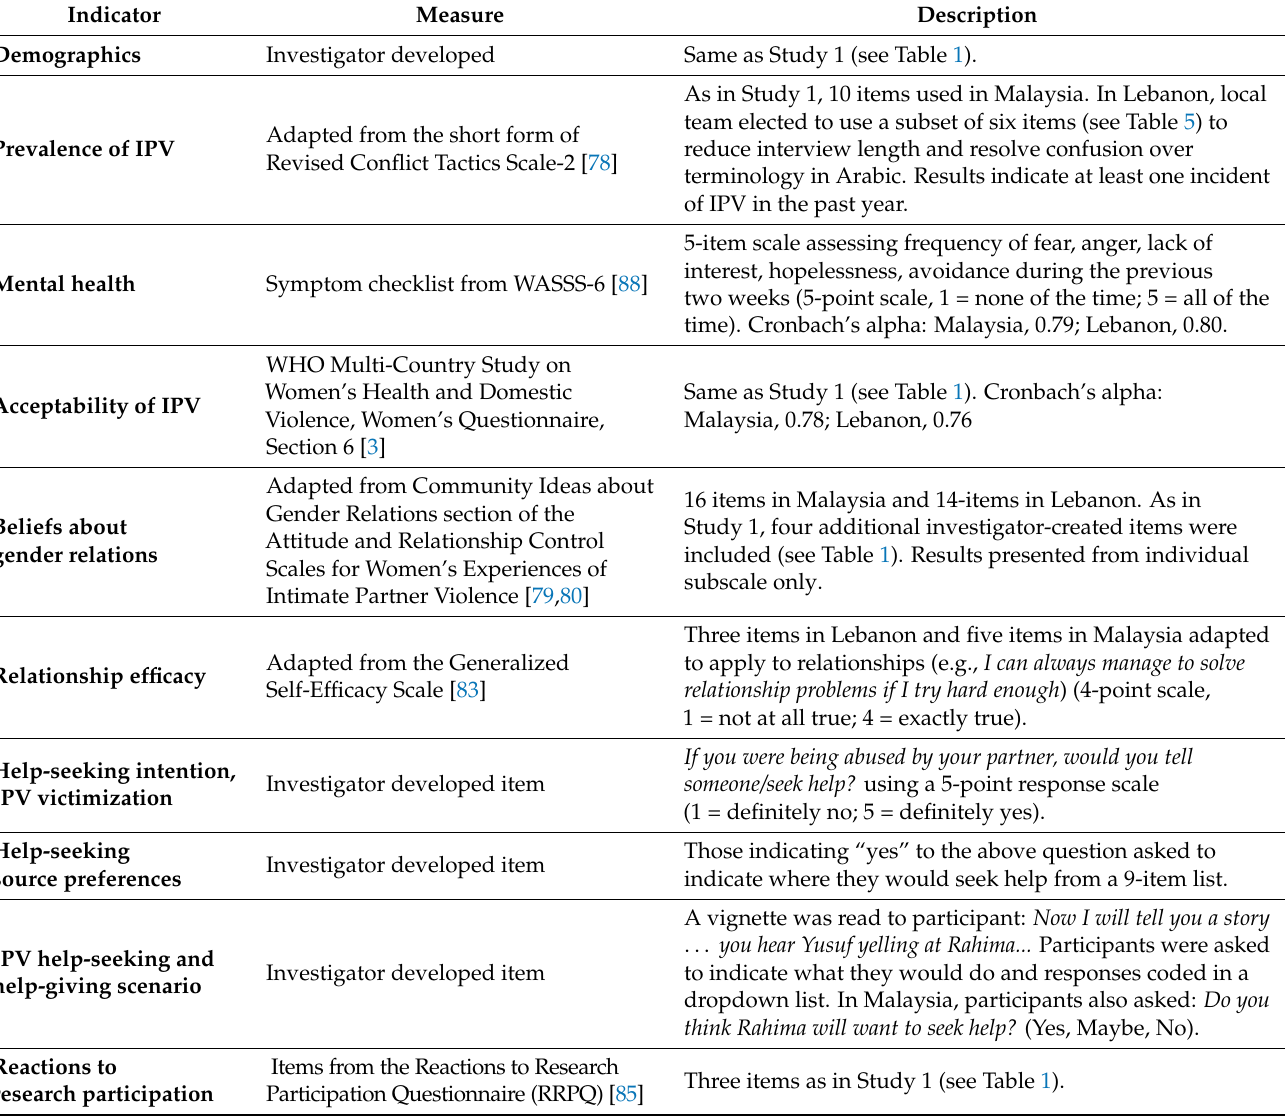
Table 4. Study 2 poster interview